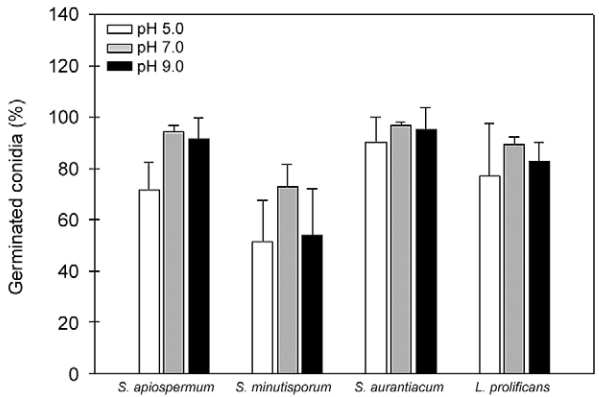
: evaluation of conidial germination of Scedosporium apiospermum, S. minutisporum, S. aurantiacum and Lomentospora prolificans in different pH values. Conidial cells were incubated for 4 h at 37ºC with an atmosphere of 5% CO2 in Sabouraud medium in which the pH was adjusted to 5.0, 7.0 and 9.0. After incubation, fungal cells were counted by using an inverted microscope. The results are shown as the mean ± standard deviation of three independent experiments. There was no statistical difference in the germination of each fungal species when cultured in different pH values.